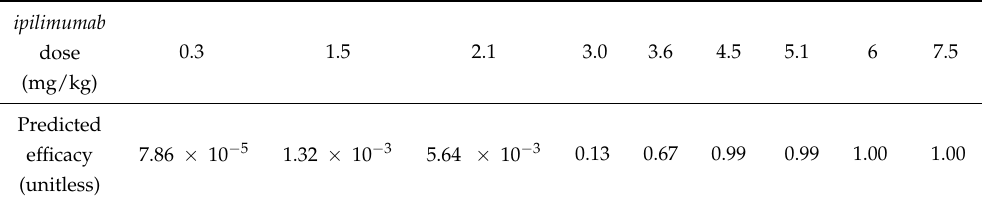
Table A2. Model predicted efficacy of the ipilimumab mono-therapy for different doses, computed by the Formula (A5). The drug is administered every 3 weks, for 4 cycles.